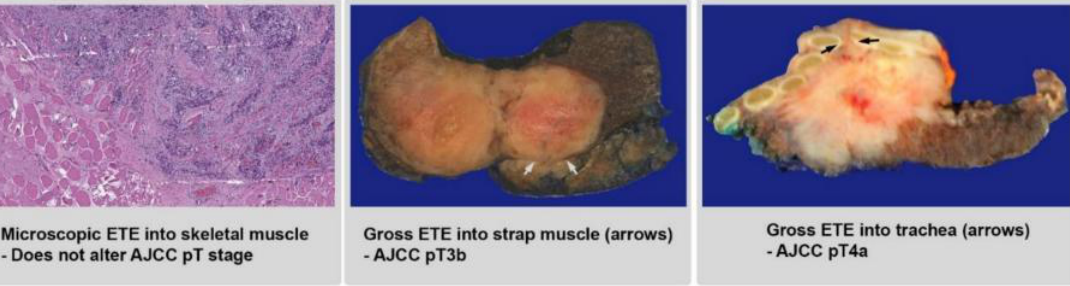
Figure 4. Extrathyroidal extension (ETE). Microscopic ETE does not a ff ect American Joint Committee on Cancer (AJCC) pT staging, whereas gross ETE into strap muscle or adjacent organs is considered AJCC pT3b and pT4a, respectively. Magnification of microscopic picture: 40 ×